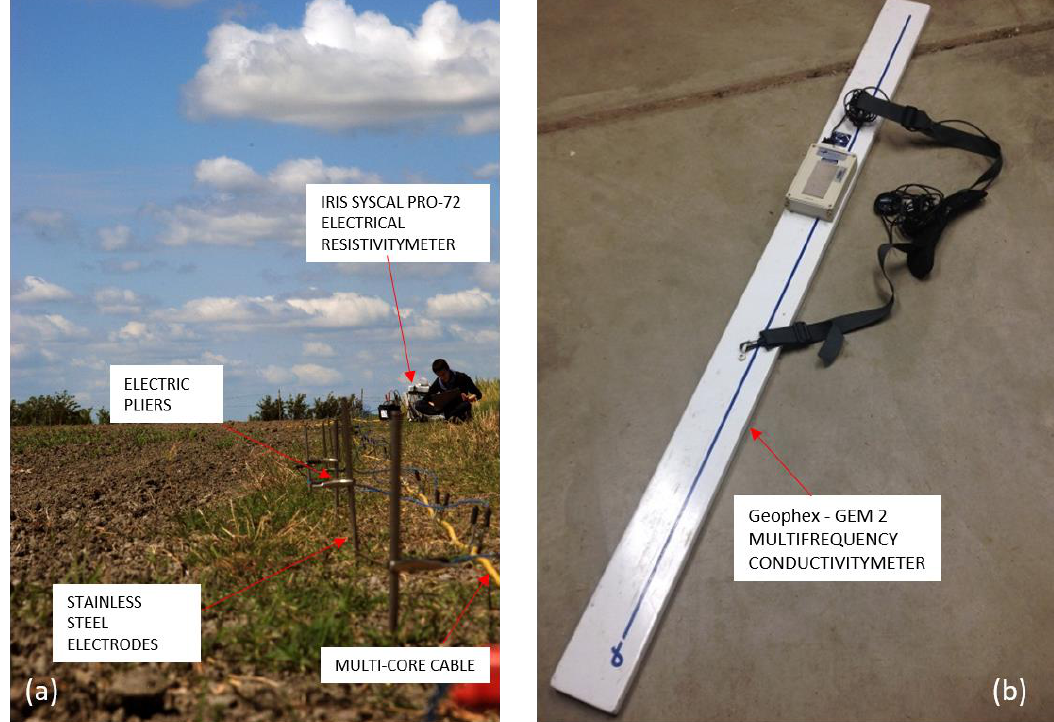
Figure 4. ( a ) ERT instrumentation during an acquisition at Fondo Paviani site; ( b ) Multifrequency conductivitymeter used for the measurements at Fondo Paviani site.